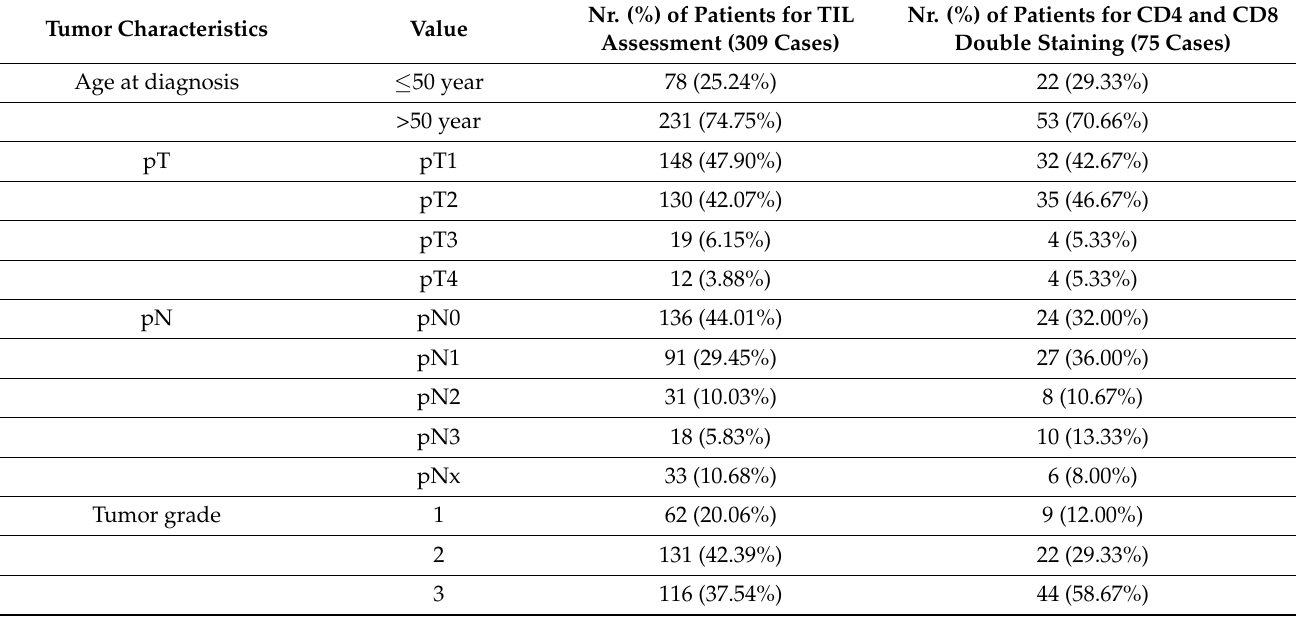
Table 1. Clinicopathological characteristics of the breast carcinoma cases analyzed in the study. Tumor